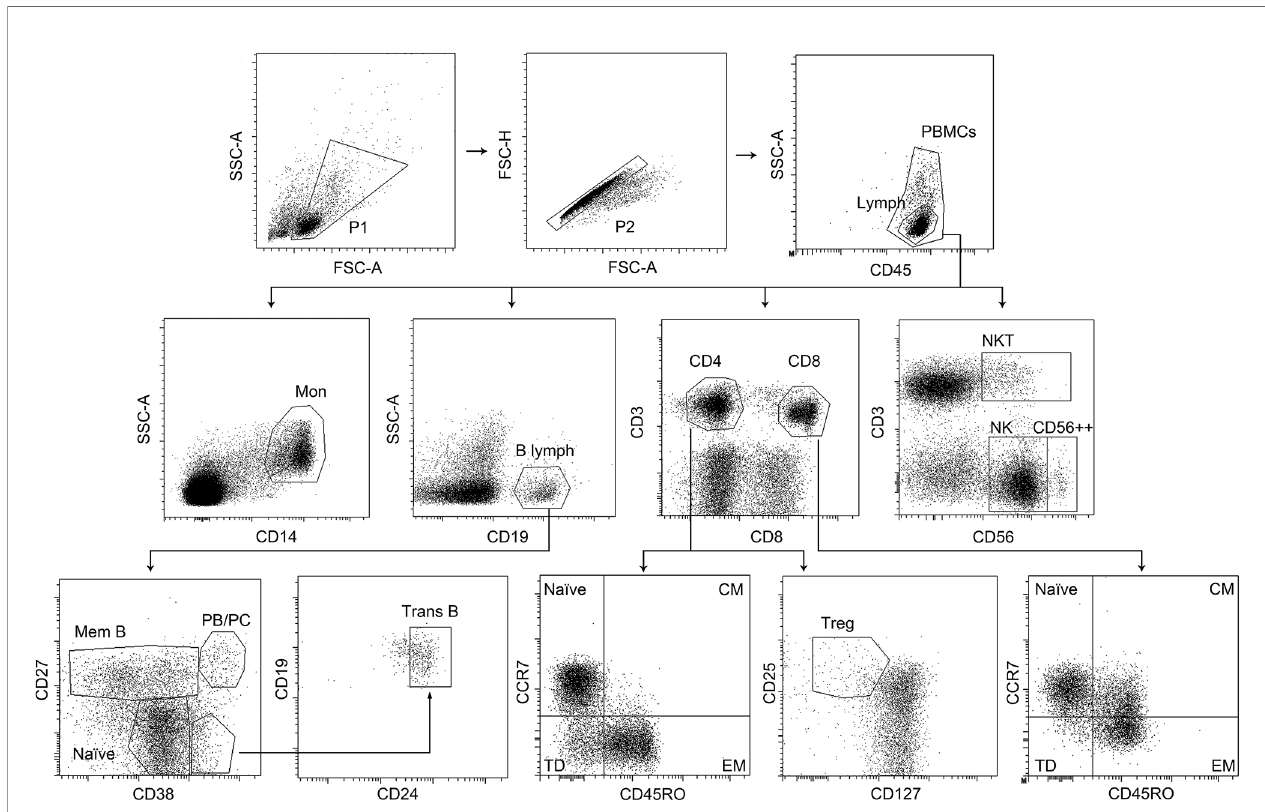
FIGURE 1 | Gating strategy showing representative images for fl ow cytometry analysis. Peripheral blood mononuclear cells (PBMC) were fi rst gated for excluding debris and apoptotic cells (gate P1) and duplets (gate P2). Lymphocytes were recognized by CD45 staining and low SSC (gate Lymph). Monocytes were recognized as CD14++ cells with intermediate SSC (gate Mon). B cells were detected by the expression of CD19 (gate B lymph) and subdivided by CD27 staining into memory cells: CD27+ (gate Mem B), naïve: CD27- (gate Naïve), plasmablasts/plasma cells: CD27hi, CD38hi (gate PB/PC), and transitional B cells: CD27-, CD38hi, CD24hi, (gate Trans B). Total CD4+ T cells were identi fi ed as CD3+ CD8- T cells (gate CD4), and CD8+ T cells were gated as CD3+ CD8++ cells (gate CD8). CD4 and CD8 T cells were classi fi ed as naïve: CCR7+ CD45RO − (gate Naïve), central memory: CCR7+ CD45RO+ (gate CM), effector memory: CCR7 − CD45RO+ (gate EM), and terminally differentiated: CCR7 − CD45RO − (gate TD). CD4+ T regulator cells were identi fi ed as CD25hi and CD127-/low (gate Treg). NK cells were identi fi ed based on their CD56 expression intensity and CD3 co-expression into CD56+ CD3- (gate NK), CD56+ CD3+ (gate NKT), and CD56++ CD3- (gate CD56++). FSC-A= Forward Scatter-Area; FSC-H= Forward Scatter-Height; SSC-A= Side